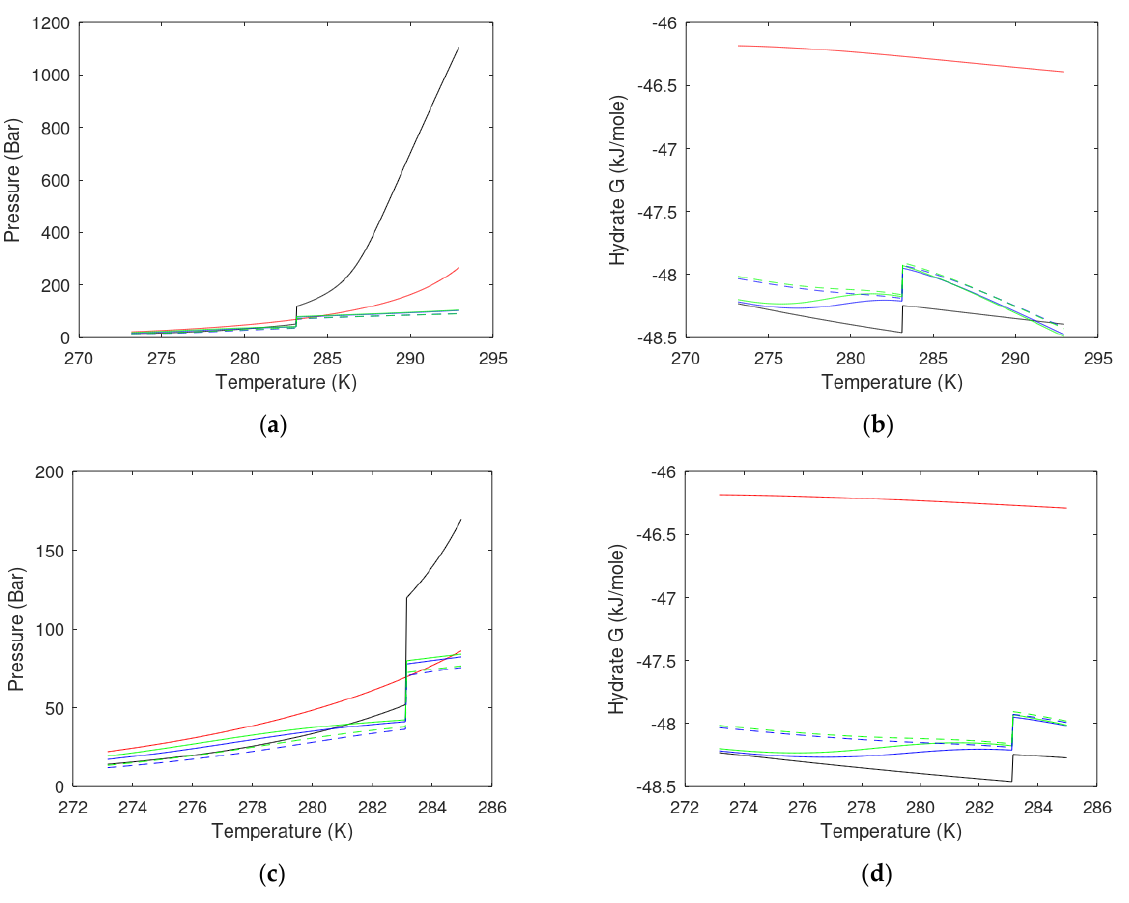
Figure 6. ( a ) Temperature pressure stability limits for the range of temperatures relevant for Danube region of the Black Sea. Red curve is CH 4 hydrate and black curve is CO 2 hydrate. Blue curve is for hydrate from 80 mole% CO 2 and 20 mole% N 2 . Green curve is for hydrate from 70 mole% CO 2 and 30 mole% N 2 . Blue dashed curve is for hydrate from 80 mole% CO 2 , 19 mole% N 2 , and 1 mole% CH 4 . Green dashed curve is for hydrate from 70 mole% CO 2 , 29 mole% N 2 , and 1 mole% CH 4 . ( b ) Gibbs free energy for the hydrates in Figure 6a. Figure 6c and d are more focused versions of Figure 6a and b and only contains the data for temperatures below 285 K.